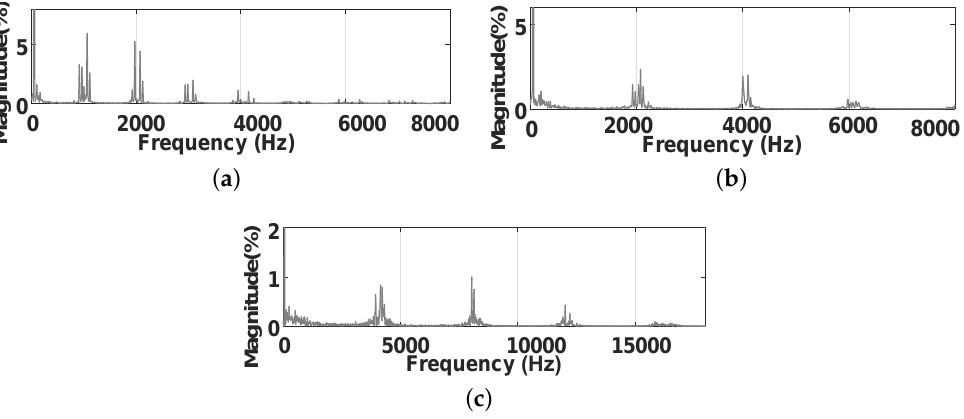
Figure 9. Different frequency concentrations using periodic control with conventional CMPC. ( a ) P-CMPC at 1 kHz; ( b ) P-CMPC at 2 kHz; and ( c ) P-CMPC at 4 kHz.